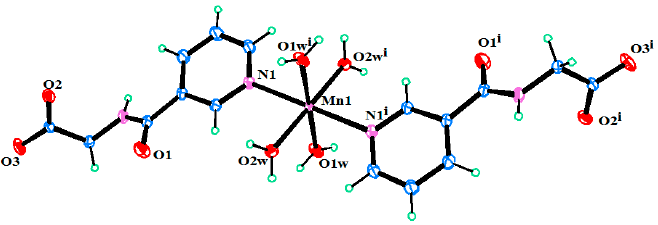
Figure 1. Coordination environment around the Mn(II) ion of complex 1 with labeling scheme at 30% ellipsoidal probability.